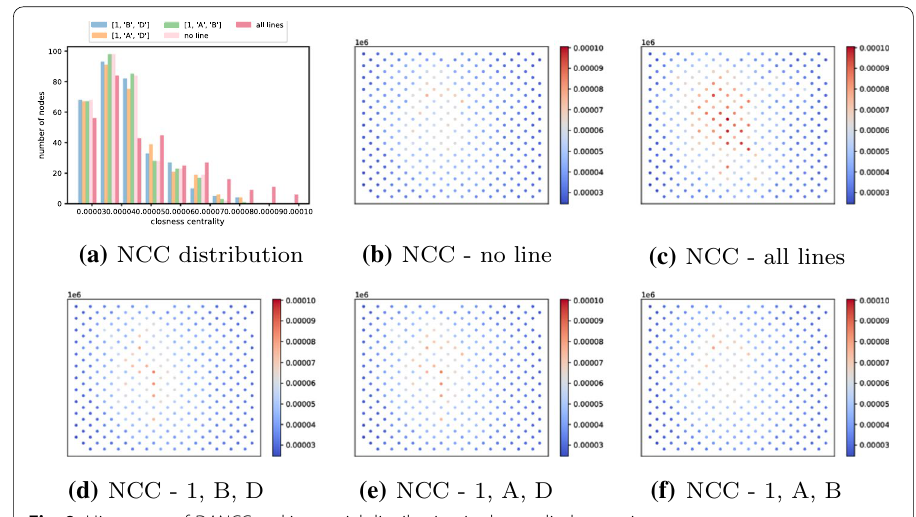
Fig. 9 Histogram of DANCC and its spatial distribution in the studied